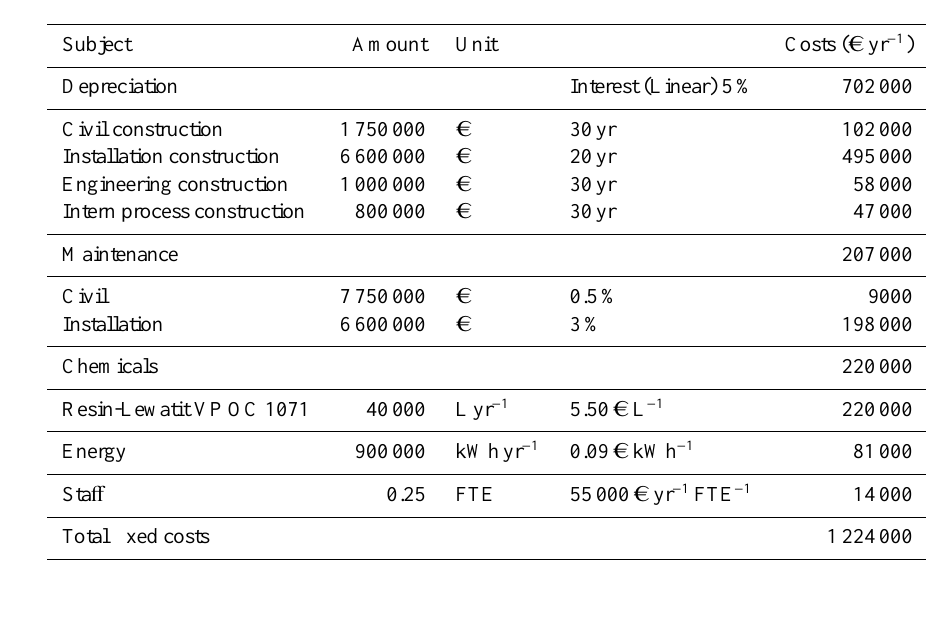
Table 3. Total fixed costs.